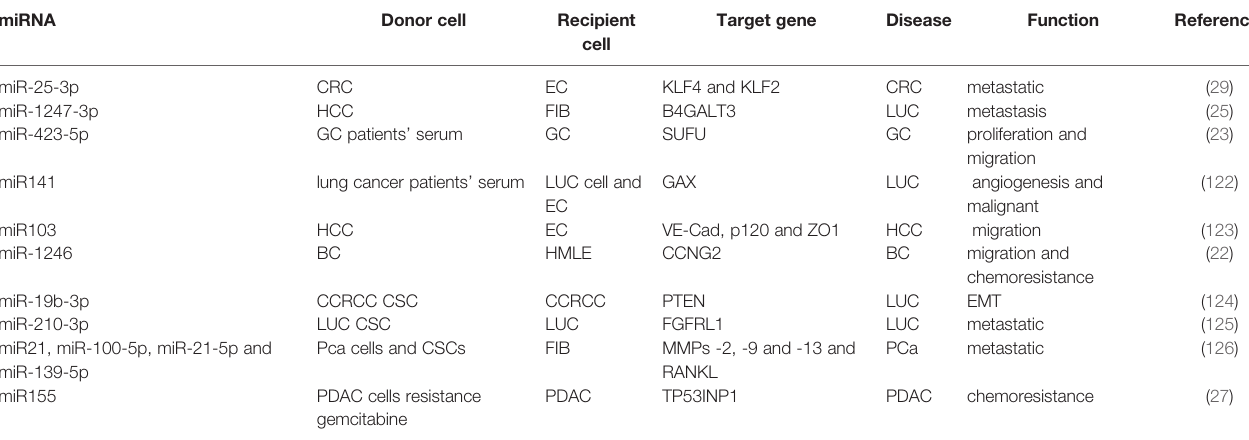
TABLE 3 | Cell interaction of exosome miRNA in cancers. miRNA Donor cell Recipient